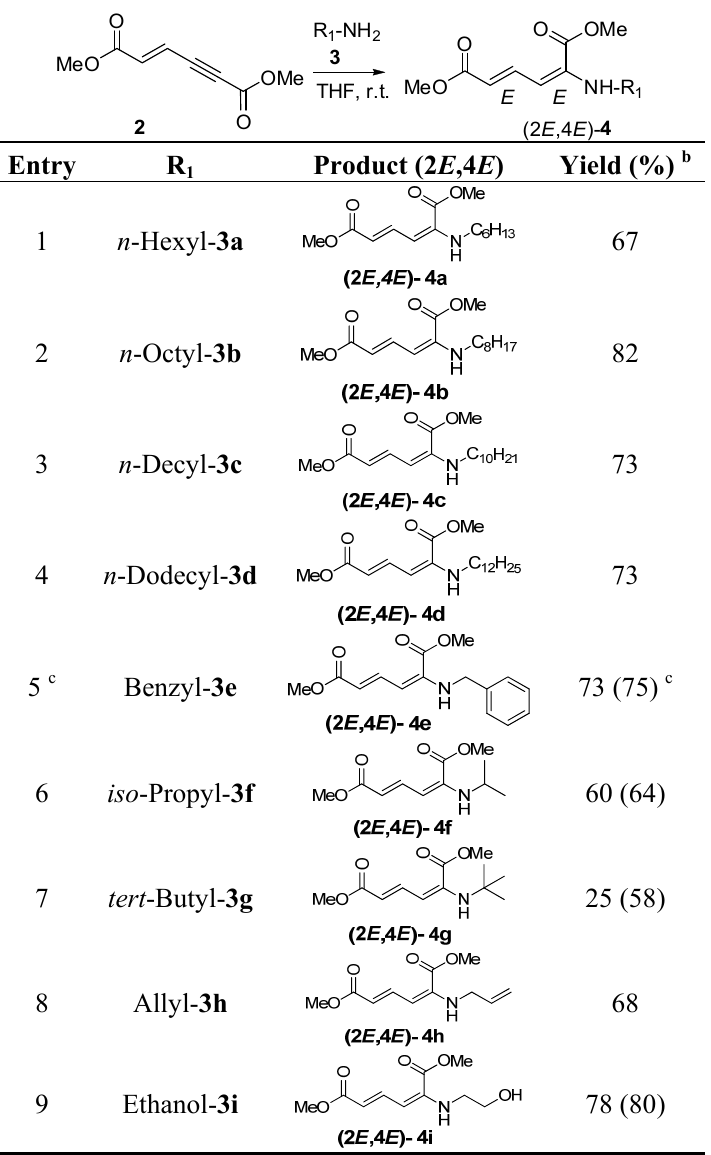
Table 2. Reaction of enyne 2 with primary alkyl amines a